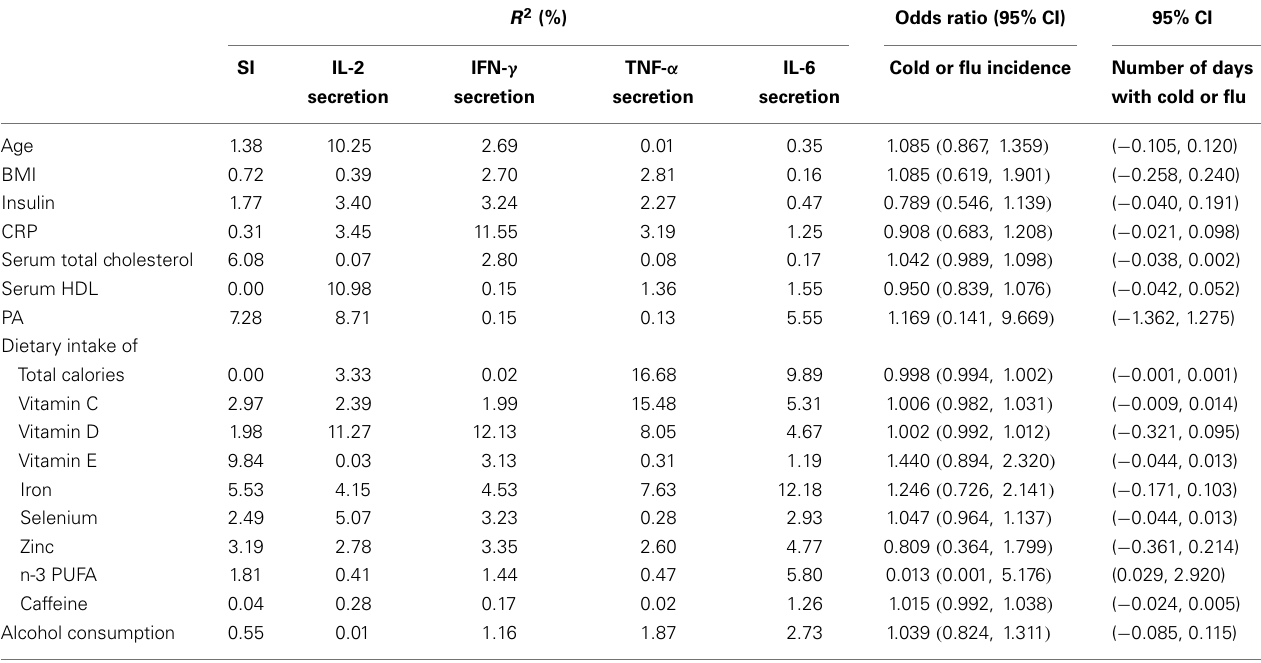
Table 2 | Contributions of individual variables to immune function and cold or flu incidence and severity a,b,c .